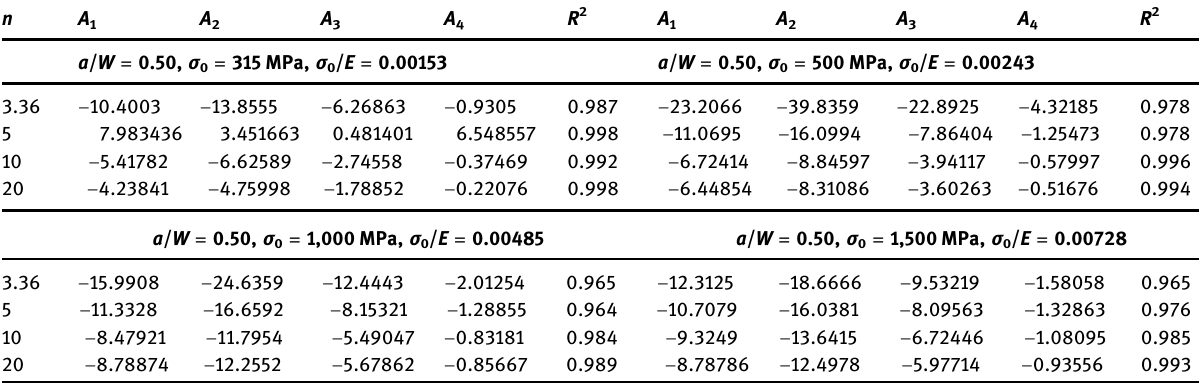
Table 13: Coe ffi cients of matching formula ( 33 ) to the numerical results for the estimation of the Q stress values, for SEN ( 4PB ) specimens dominated by the plane strain state, with the relative crack length a / W =